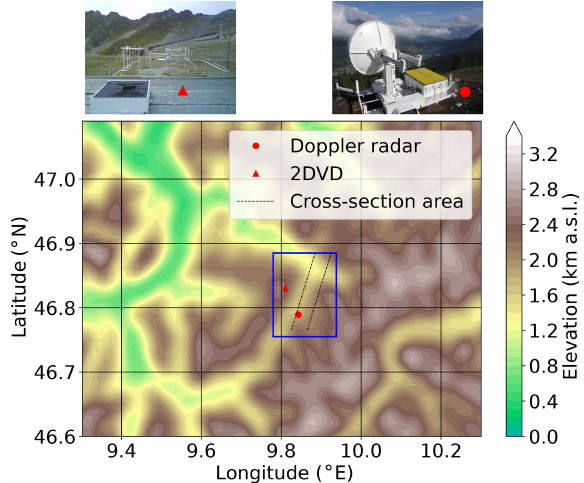
Figure 1. Overview of the model orography and the instrument lo- cation setup. The parallelogram (dashed black lines) is the domain of the flow-oriented vertical cross-section analysis in Sect. 3.1 fol- lowing the direction of the dual-polarized Doppler radar MXPol (red dot located at 46.789 ◦ N, 9.843 ◦ E) data. The blue box is the domain used for analysis in Sect. 3.2 and 3.3. The red triangle is the location of the ground-based video